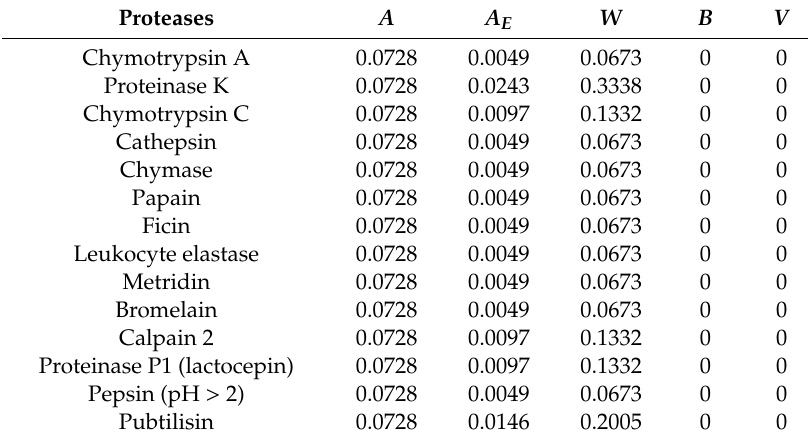
Table 2. The values of parameters describing the predicted e ffi ciency of release of the bioactive antioxidative fragment from Halophila stipulacea -RubisCO by